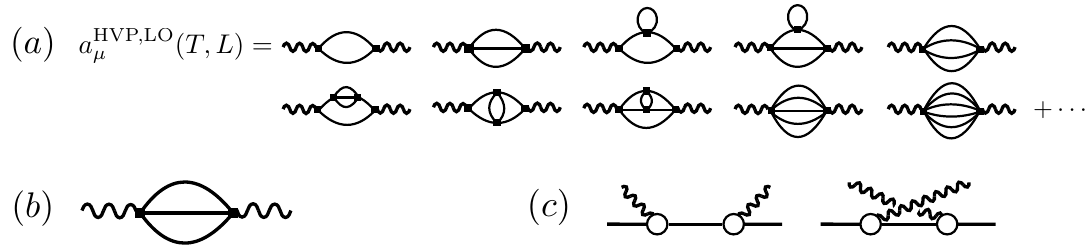
Figure 1 . (a) Examples of diagrams appearing in the all-orders expansion. (b) Sunset diagram that generates a (cid:12)nite-volume e(cid:11)ect beyond the order we control. (c) Single-pion exchange diagrams in the pion Compton scattering amplitude. Here the white circles denote the pion form factor, F ( k 2 ) sampled for space-like k 2